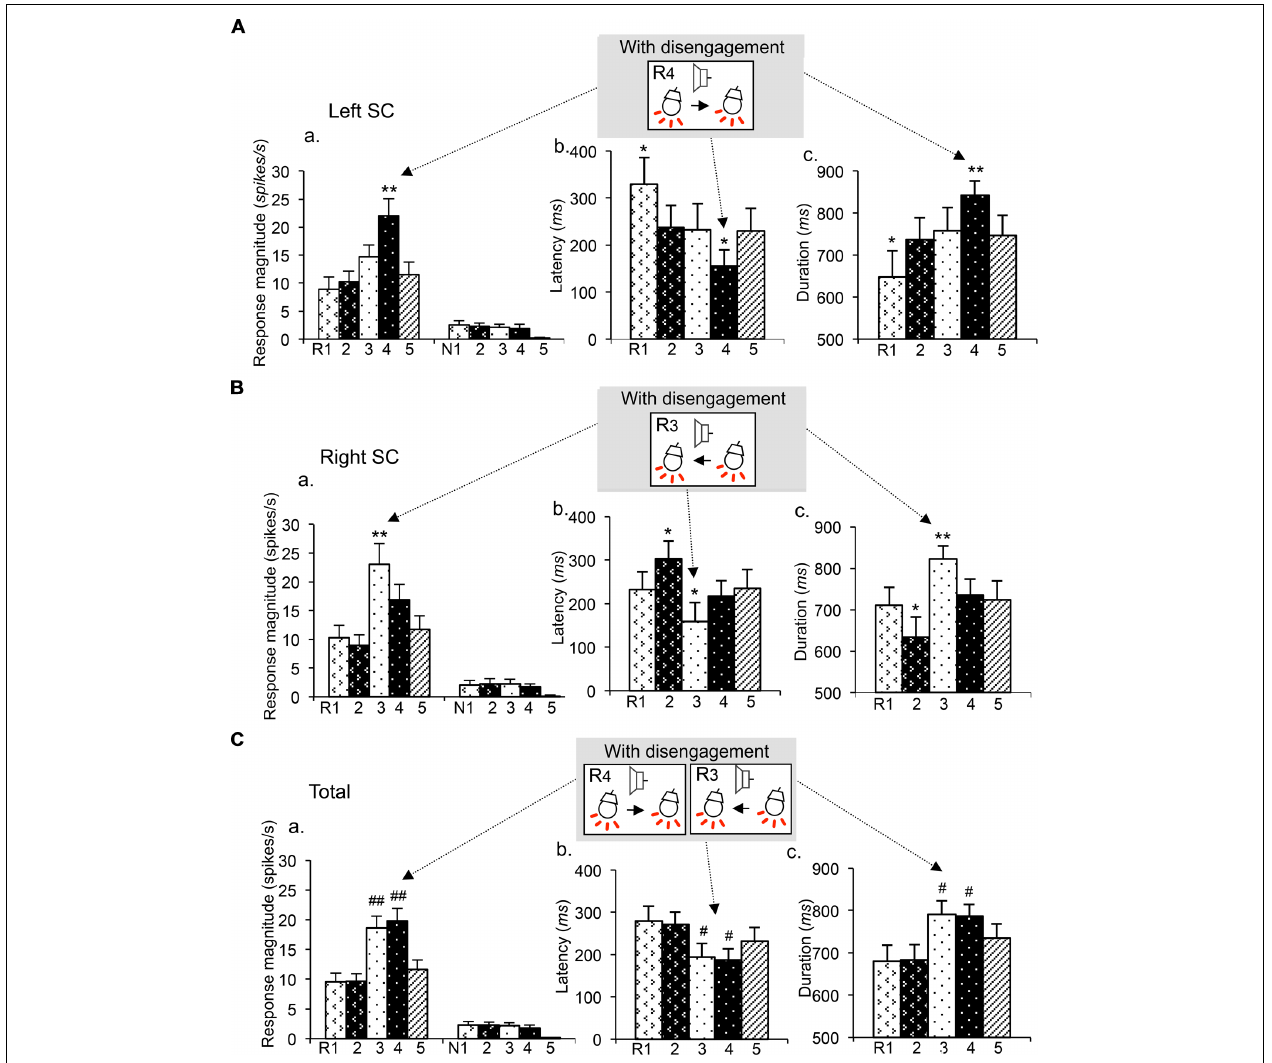
FIGURE 4 | Mean response magnitudes (a), latencies (b), and durations (c) of the attention disengagement-related neurons. (A) Attention disengagement-related neurons ( n = 22) recorded from the left SC.The mean response magnitude to the CSs was stronger (a), the mean response latency was shorter (b), and the mean response duration was longer (c) in session 4 than other sessions. **, *significant differences from the CSs in the reward trials of other sessions (Bonferroni test, P < 0.01, P < 0.05, respectively). (B) Attention disengagement-related neurons ( n = 19) recorded from the right SC.The mean response magnitude to the CSs was stronger (a), the mean